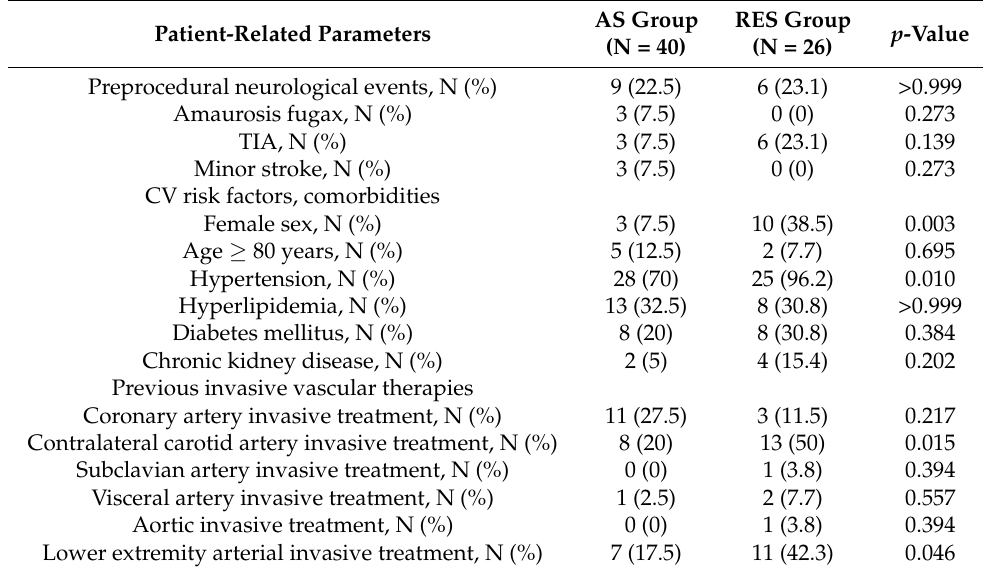
Table 1. Preprocedural neurological events, cardiovascular risk factors, comorbidities, and previous invasive vascular